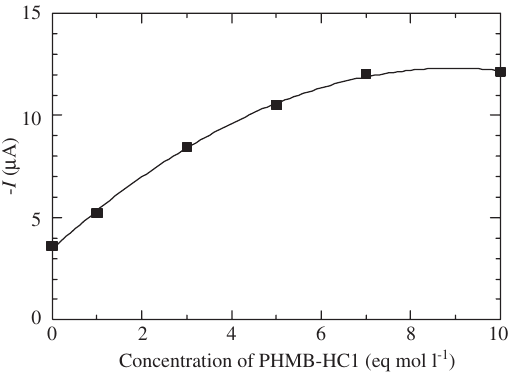
Figure 9 Voltammograms of 5-Br-PAPS (10 -5 m) in the presence of 5x10 -6 eq mol l -1 PHMB-HCl in 0.01 m H indicates a base voltammogam without PHMB-HCl.